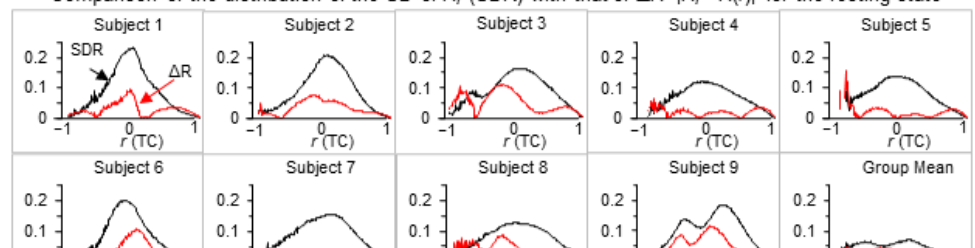
p = 0.23 Table 2. The mean value of the distribution (Figure 2) averaged over all 200 r values for the standard deviation (SD) of 𝑅 𝑟 and the absolute value of the difference between 𝑅 𝑟 and R ( r ) (i.e., Δ R = | 𝑅 𝑟 − R ( r )|), respectively, for the resting and task states. Note that the last row shows these mean values computed with their corresponding group mean distributions in Figure 2 (the last plot in the second and fourth panels). Subject Resting State